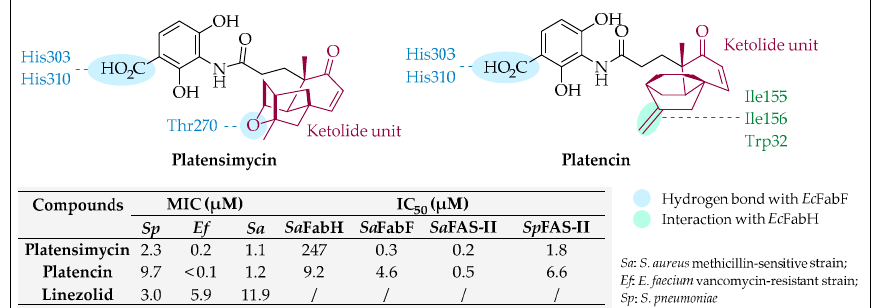
Figure 6. Structures, in vitro activities and representation of main interactions with Ec FabF/H of platensimycin and platencin [66,69].